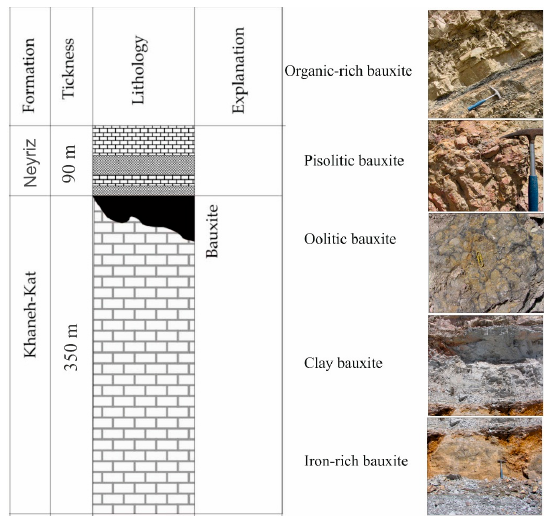
Figure 4. Schematic profile of the Dopolan bauxite deposit; on the right diverse bauxite facies.